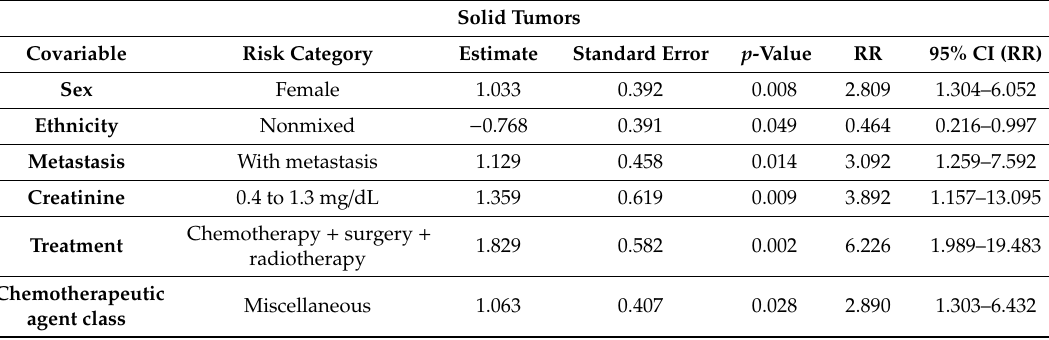
Table 3. Estimated of parameters and relative risk (RR) corresponding to the final model for patients with solid tumors treated at Napole ã o Laureano Hospital,